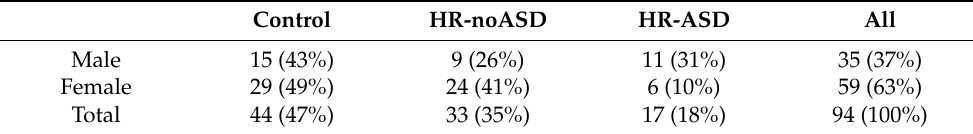
Table 1. The number of participants available for analysis from each group: high-risk infants who